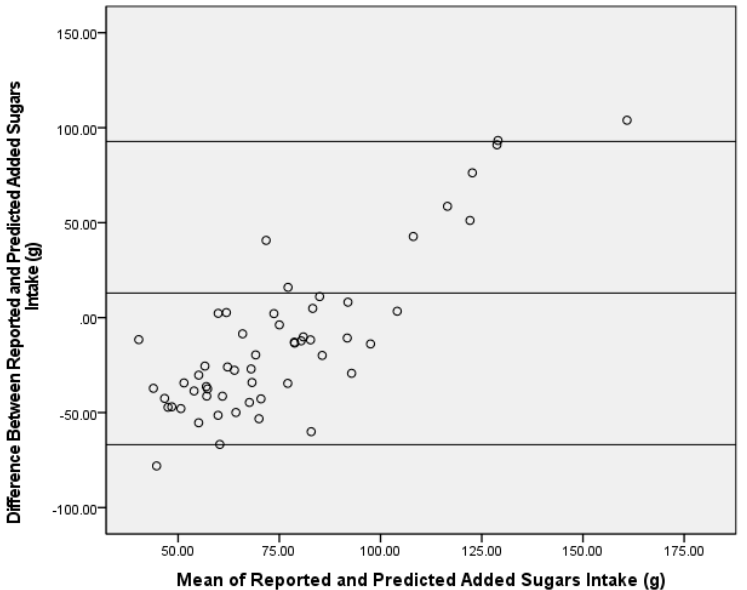
Figure 3. Bland–Altman analysis of reported and predicted added sugars intake (g) using a δ 13 C and δ 15 N dual-carbon stable isotope ratio prediction model in the test group ( n = 56) . * The center line represents the mean difference, and the upper and lower lines indicate the mean ± 1.96 standard deviation.